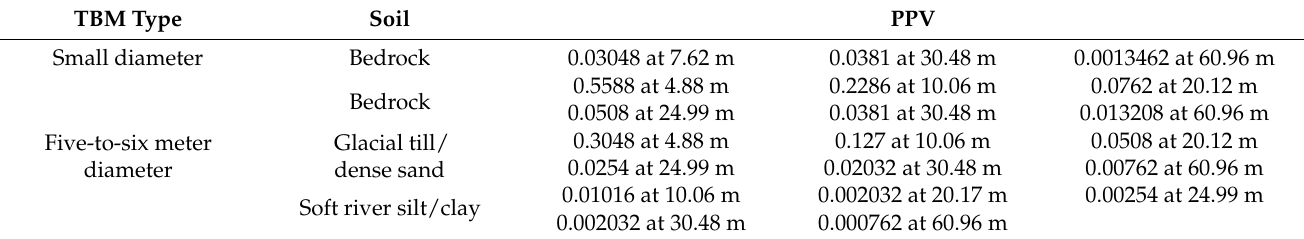
Table 5. TBM vibration levels